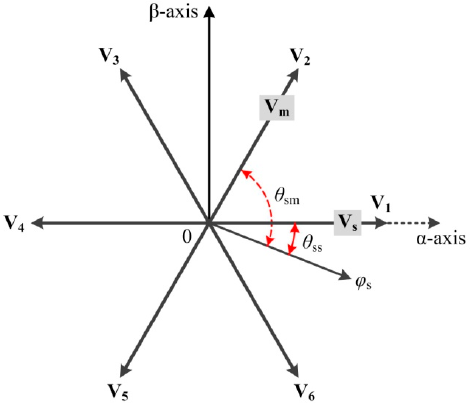
Figure 2. Relationships of the variables in the control system driven by fixed sector division criterion(FS-DTC).